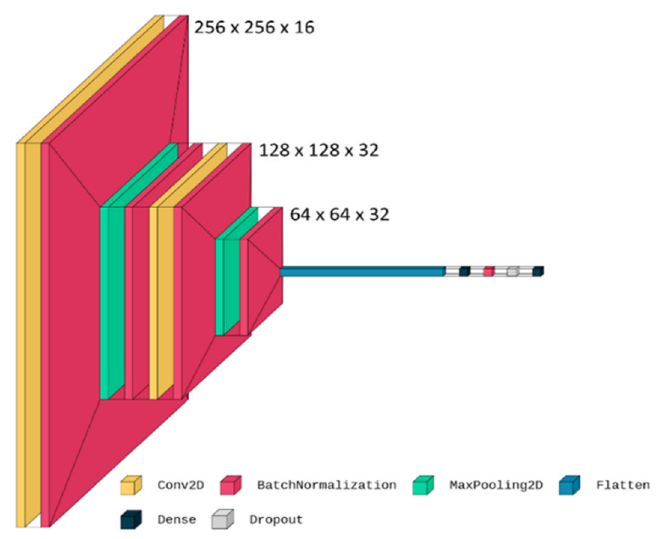
Figure 3. Proposed CNN architecture.